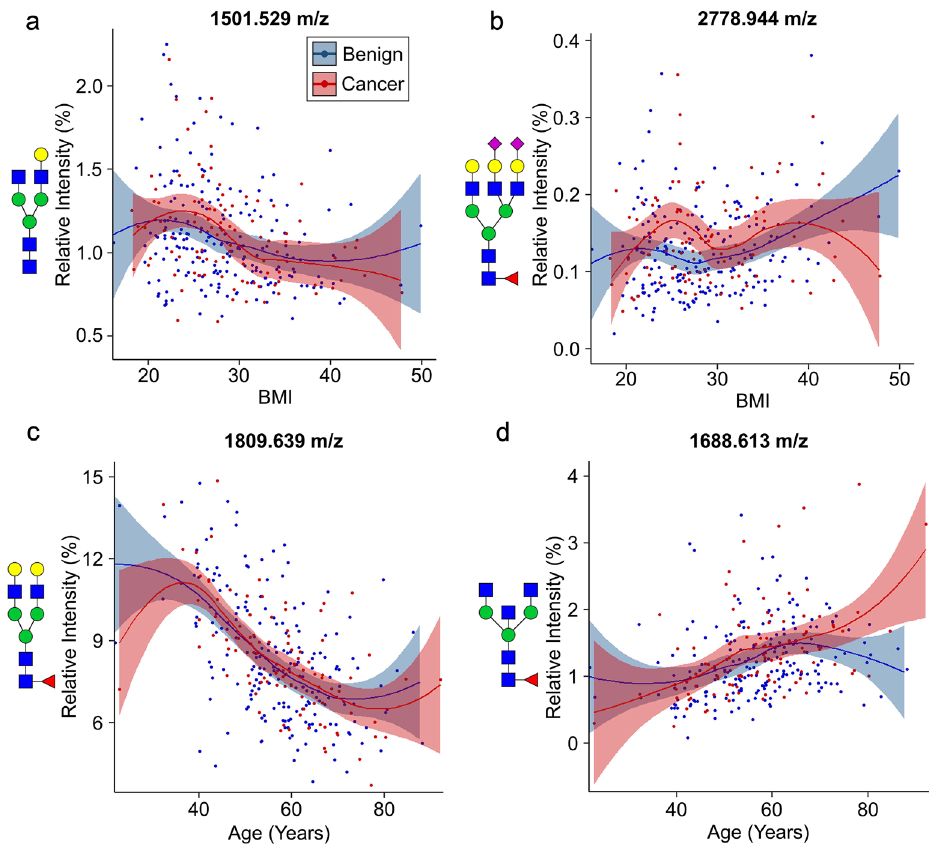
Figure 4. Correlation of serum N-glycan intensities with the patient age and BMI. The patient BMI and the intensities of both ( a ) 1501.529 m/z (A2G1) and ( b ) 2778.944 m/z (A3G3F1S2) N-glycans, but the 2778.944 m/z N-glycan and BMI association diverged for benign and cancer samples in the patients with a BMI from 20 to 30. The patient age and the intensities of both ( c ) 1809.639 m/z (A2G2F1) and ( d ) 1688.613 m/z (A2BF1) N-glycans were significantly associated, but the 1688.613 m/z N-glycan and age association diverged for benign and cancer samples in the older patients. N-glycan compositions are represented by blue squares for N-acetylglucosamine, green circles for mannose, yellow circles for galactose, purple diamonds for sialic acid, and red triangles for